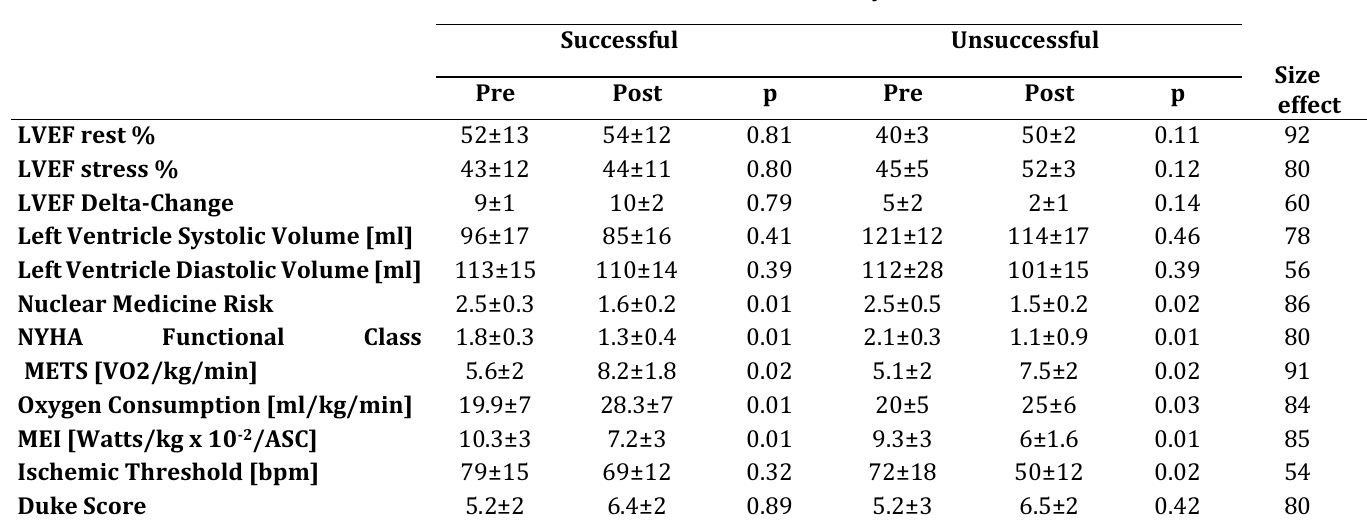
Table 2: Cardiac Rehabilitation and Secondary Prevention Program (CRS&SPP) effect in patients with Percutaneous Coronary Intervention successful and